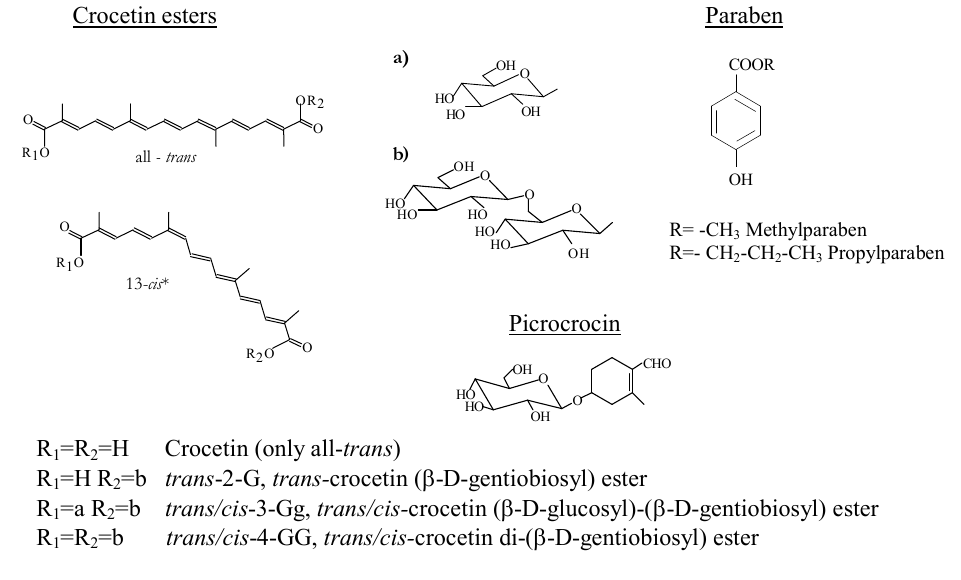
Figure 1. Structure of crocetin esters, picrocrocin and parabens. In the case of crocetin esters with cis -configuration, the position of the substitutes R determined in relation to the C13-14